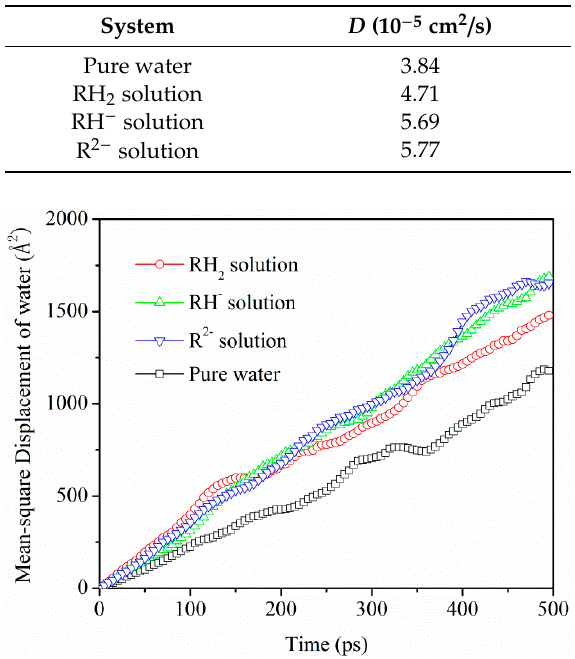
Table 3. Di ff usion coe ffi cient ( D ) for interfacial water molecules in the system of pure water, RH 2 , RH − , and R 2 − solutions on barite (001) surface as obtained from their mean square displacements.